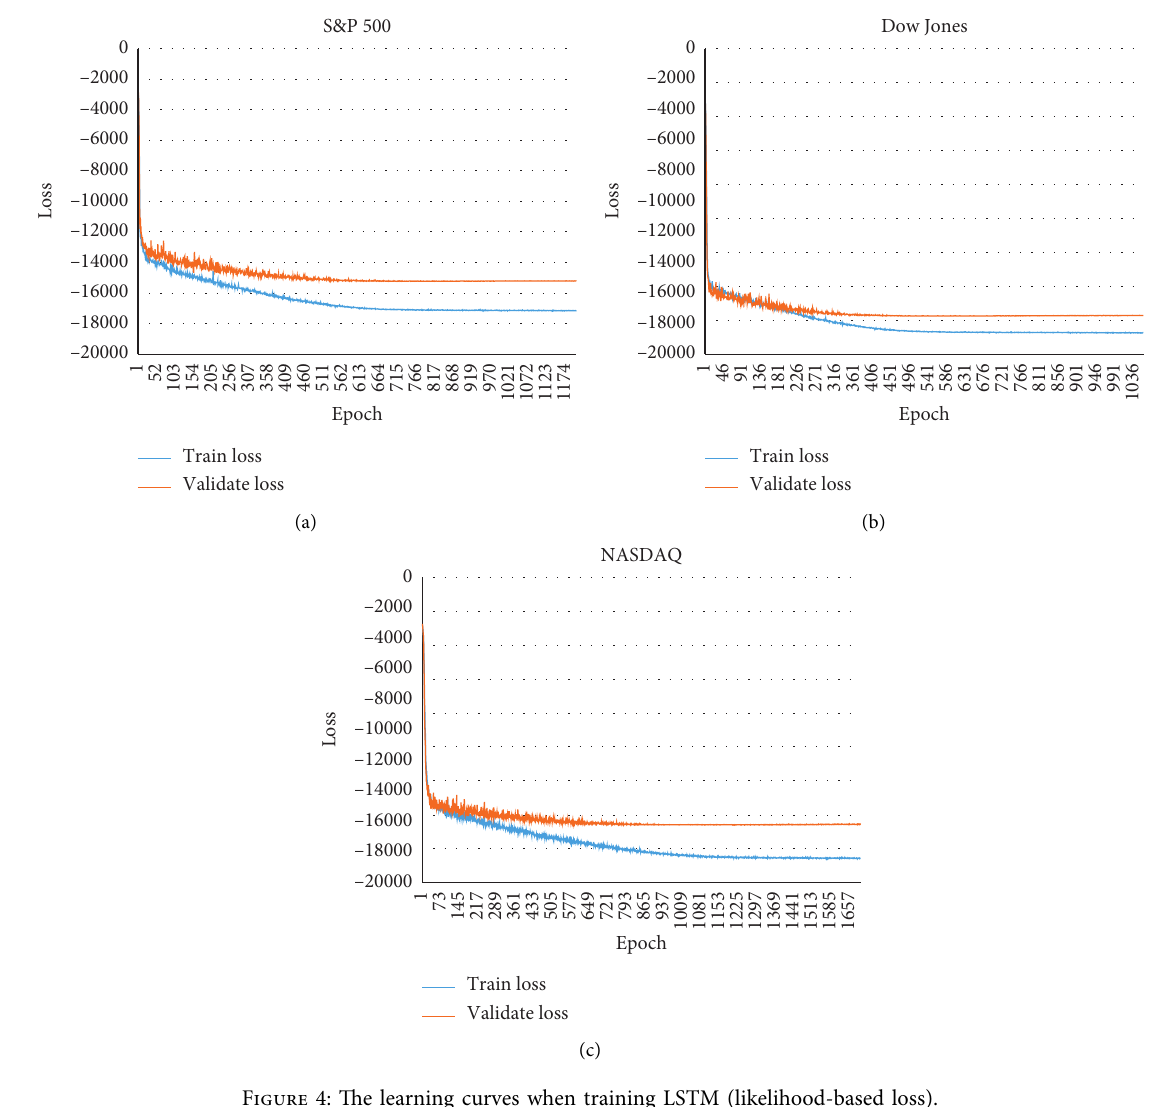
Figure 4: The learning curves when training LSTM (likelihood-based loss).